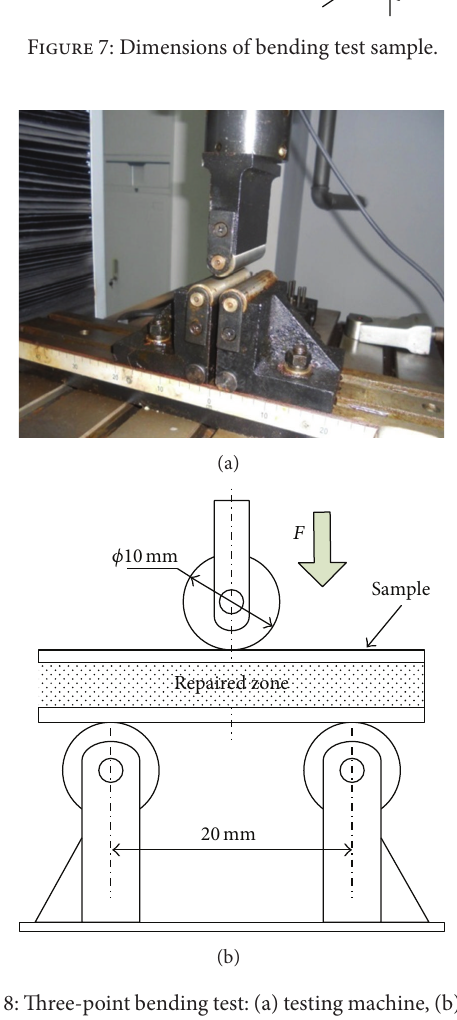
Figure 8: Three-point bending test: (a) testing machine, (b) loading sketch.